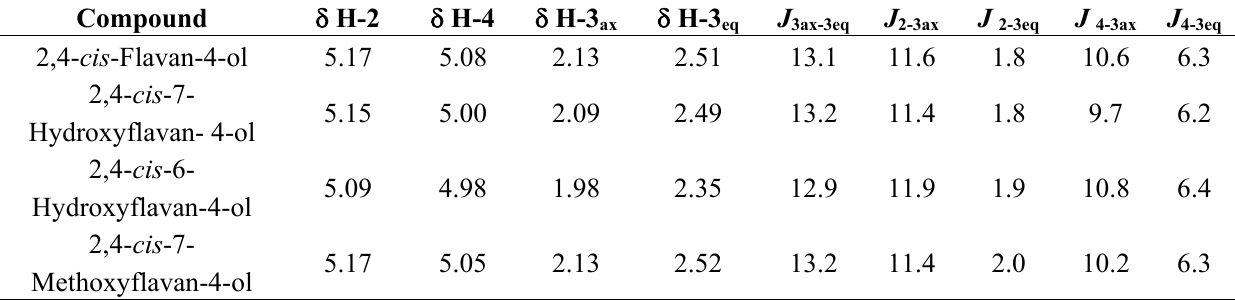
Table 1. Selected 1 H-NMR data for 2,4- cis -flavan-4-ol [20],